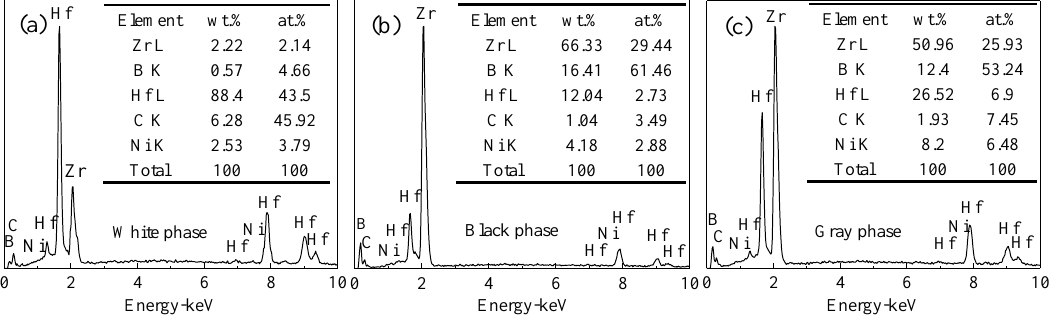
Figure 3. Energy dispersive spectrometer (EDS) measured at 30 kV of the phases in ZrB 2 –HfC ceramics: ( a ) EDS of point A for the white phase, ( b ) EDS of point B for the black phase, and ( c ) EDS of point C for the grey phase defined in Figure 2.